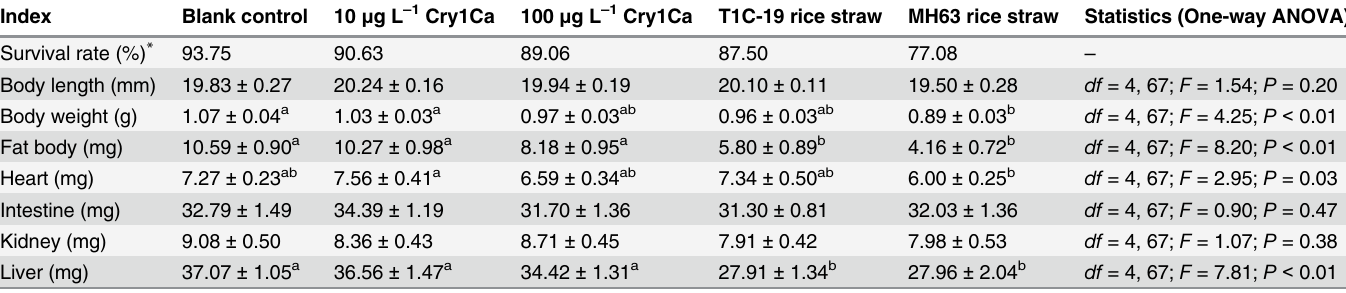
Table 3. Survival and development of Xenopus laevis tadpoles exposed to purified Cry1Ca protein, transgenic cry1Ca rice (T1C-19) straw and non-transformed isoline (MH63) straw. The experiment was initiated with 64 (n = 16 for 10, 100 μ g L – 1 Cry1Ca protein and blank control groups) or 48 (n = 12 for T1C-19 and MH63 rice straw groups)